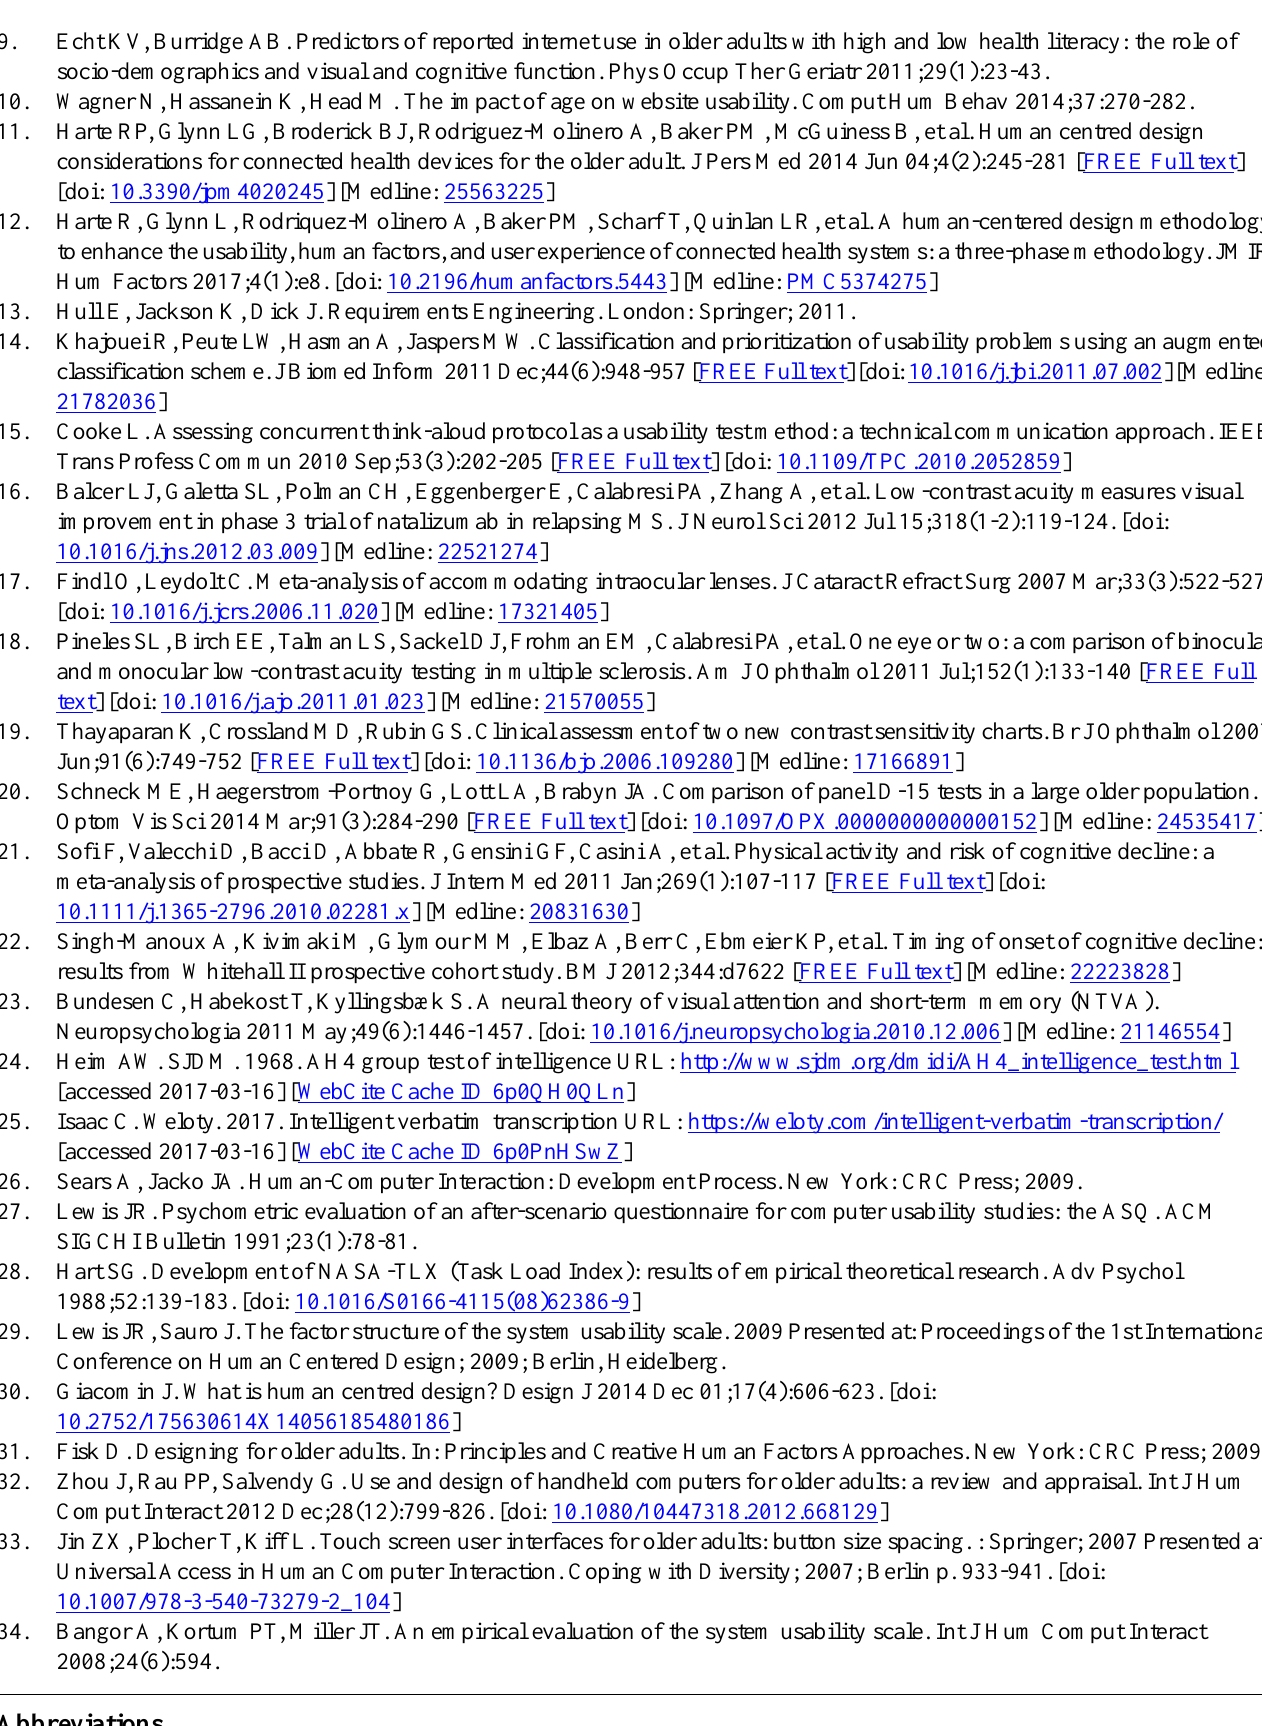
ADL: acitivities of daily